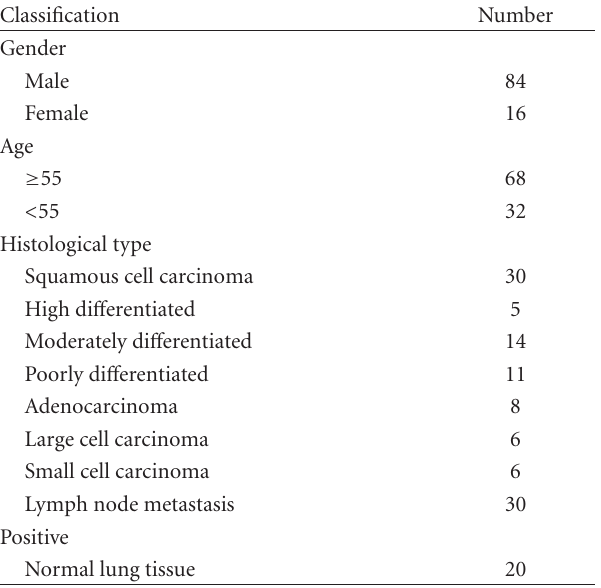
Table 1: The clinicopathological parameters of the 100 tissue